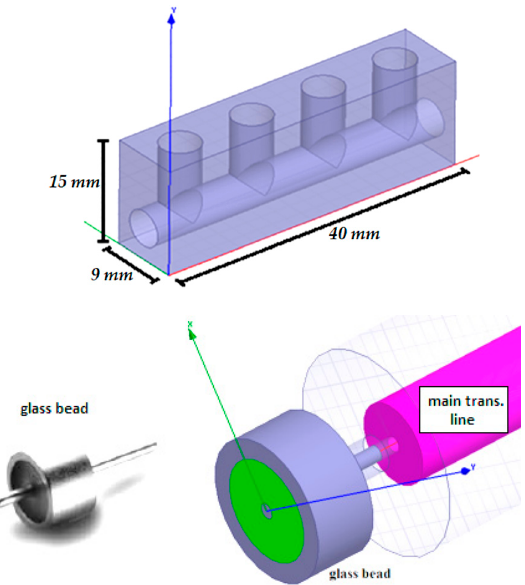
/ output port ( bottom